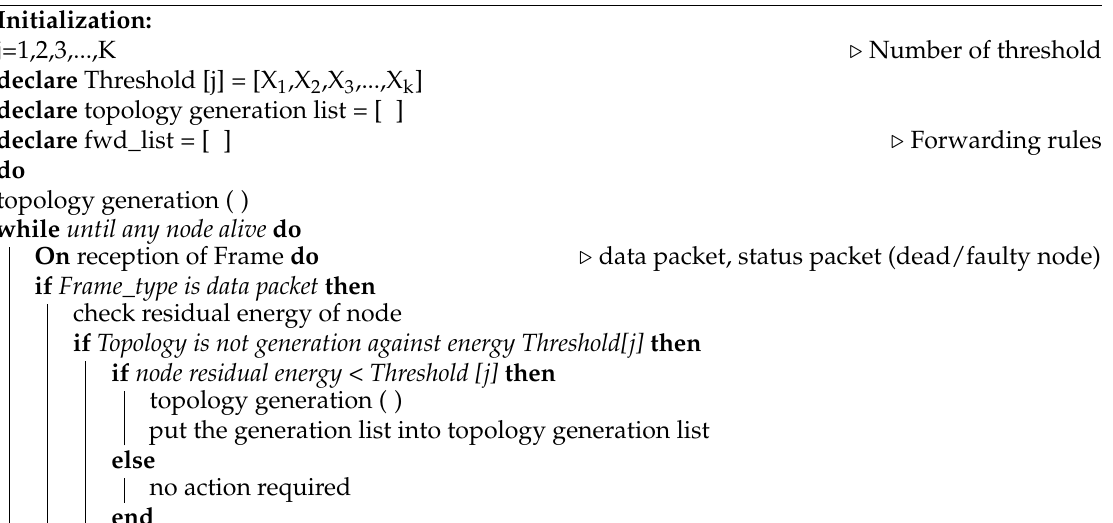
Algorithm 3 Controller operational phase